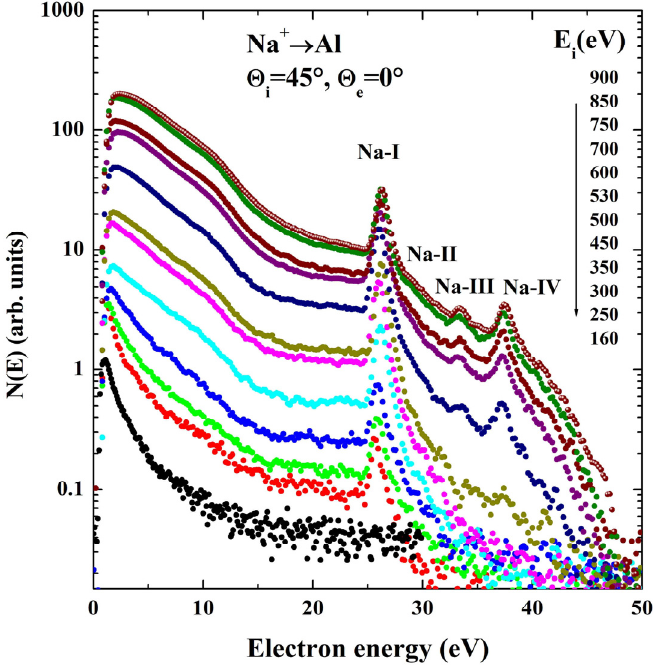
Figure 5. Energy spectra of electrons emitted from the Al surfaces under the impact of Na + ions at varying the energy of incoming ions, for fixed incidence and observation angles.